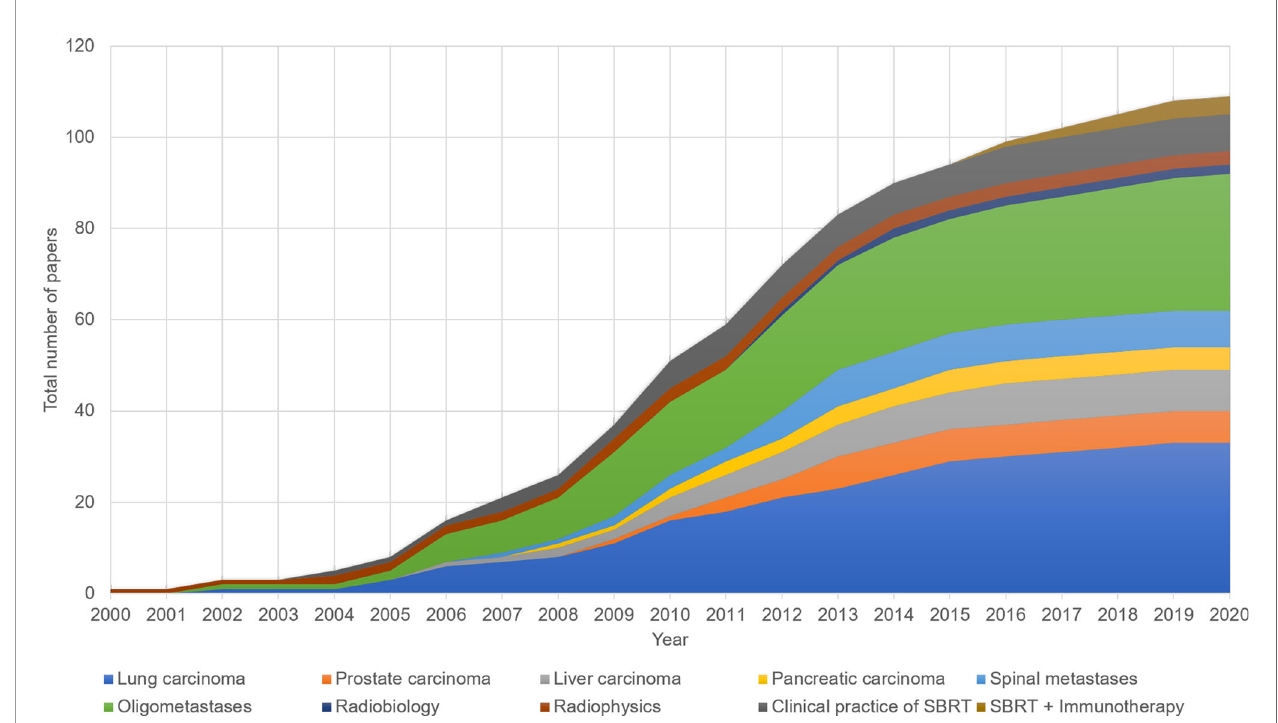
FIGURE 5 | The annual publication counts of the 10 subdivided domains of SBRT.